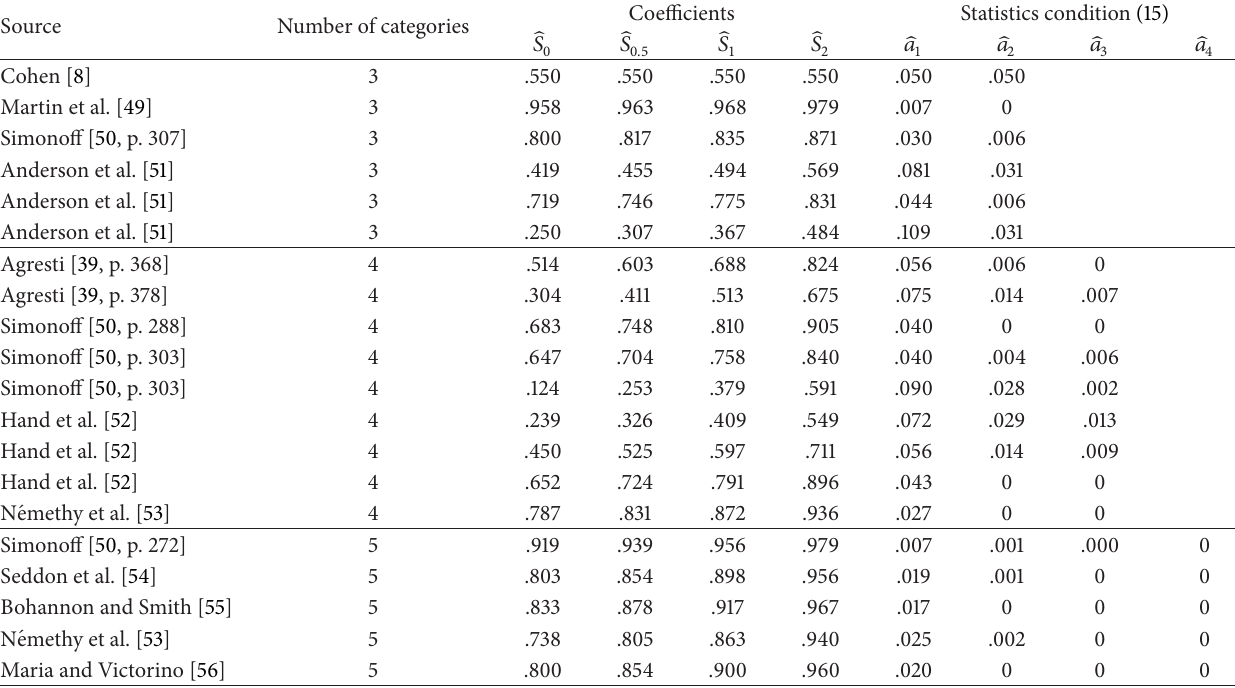
Table 2: Various statistics for 20 agreement tables from the literature.